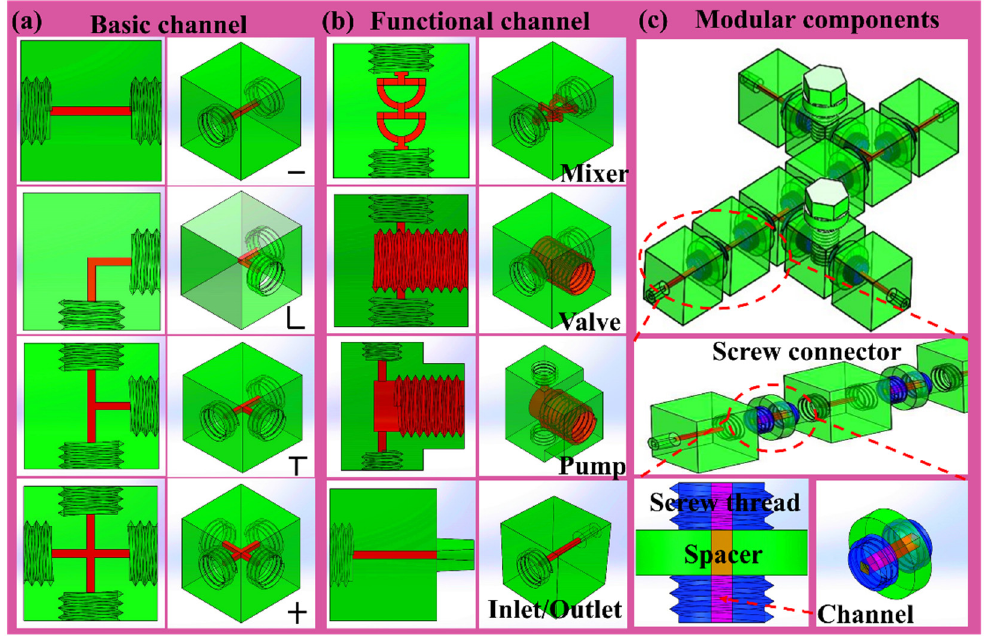
Figure 1. Schematic illustration of 3D printed microfluidic modular components. ( a ) basic microchannel unit. ( b ) functional microchannel unit. ( c ) multifunctional microfluidic system. The device consists of multiple basic channels and functional channels using screw connector.